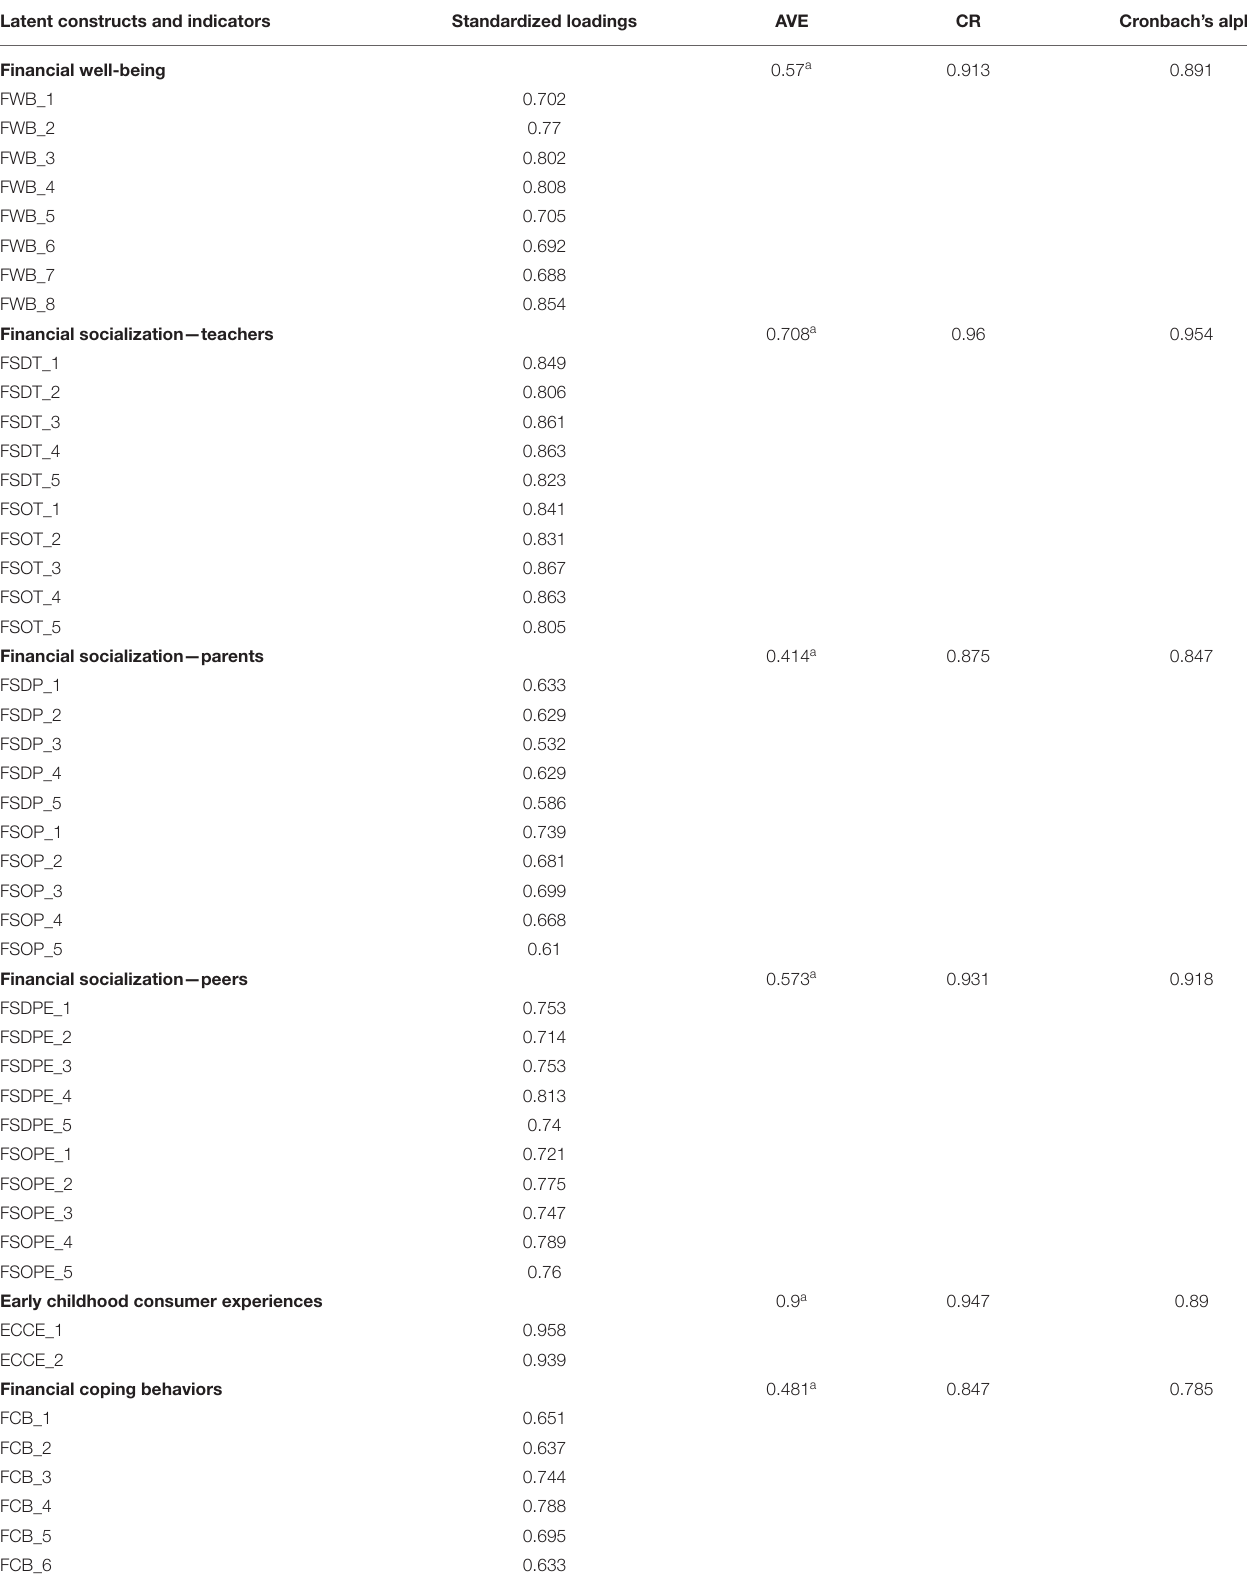
TABLE 3 | Factor loadings, average variance extracted, and composite reliability. Latent constructs and